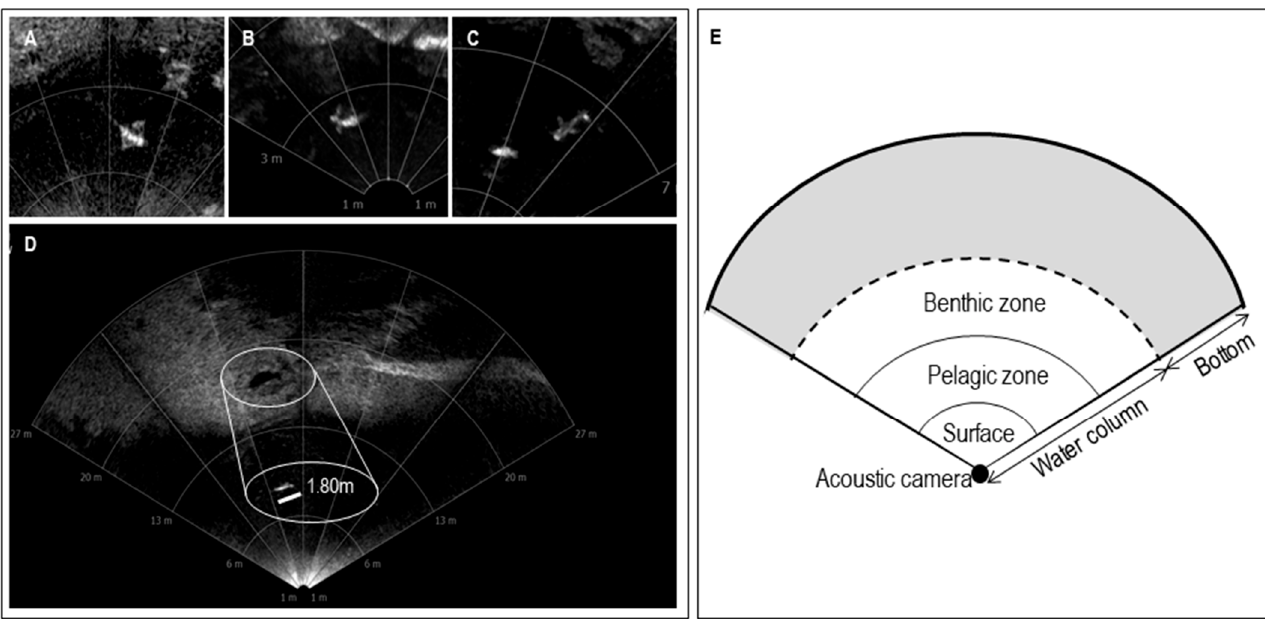
Figure 4. Detection of a ray ( A ), a marine turtle ( B ), a shark ( C ), a goliath grouper ( Epinephelus itajara ) with its corresponding acoustic shadow ( D ) and scheme of the determination of the fish position in the water column ( E ) with a P900-130 BlueView acoustic camera.